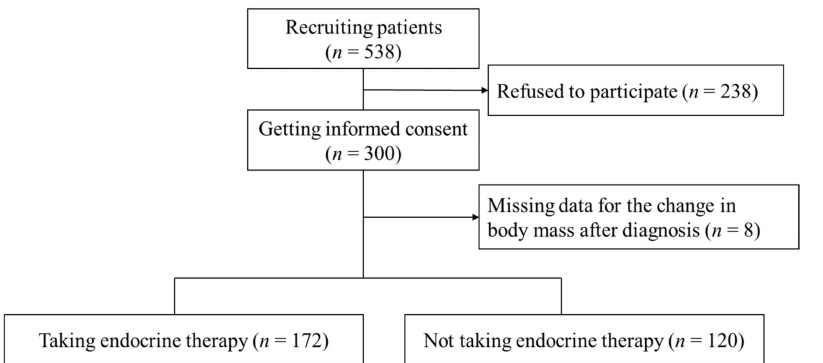
Figure 1. Flowchart of the study patients (Tokyo,